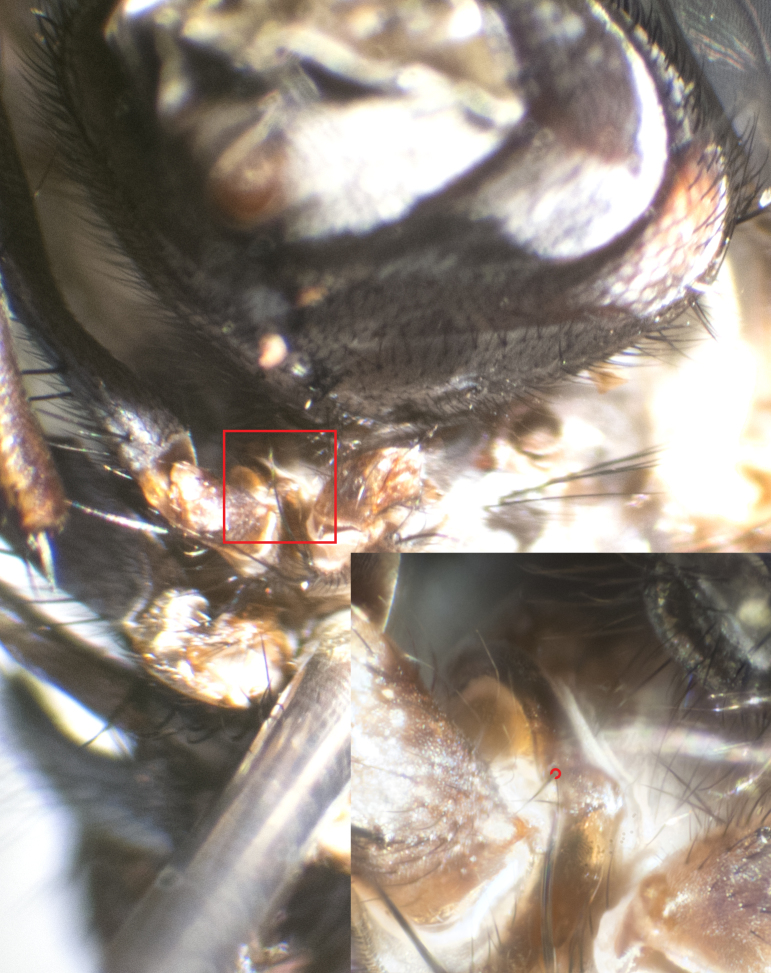
Detailed view of hind coxa showing setose hind margin in Hyphantrophaga
virilis